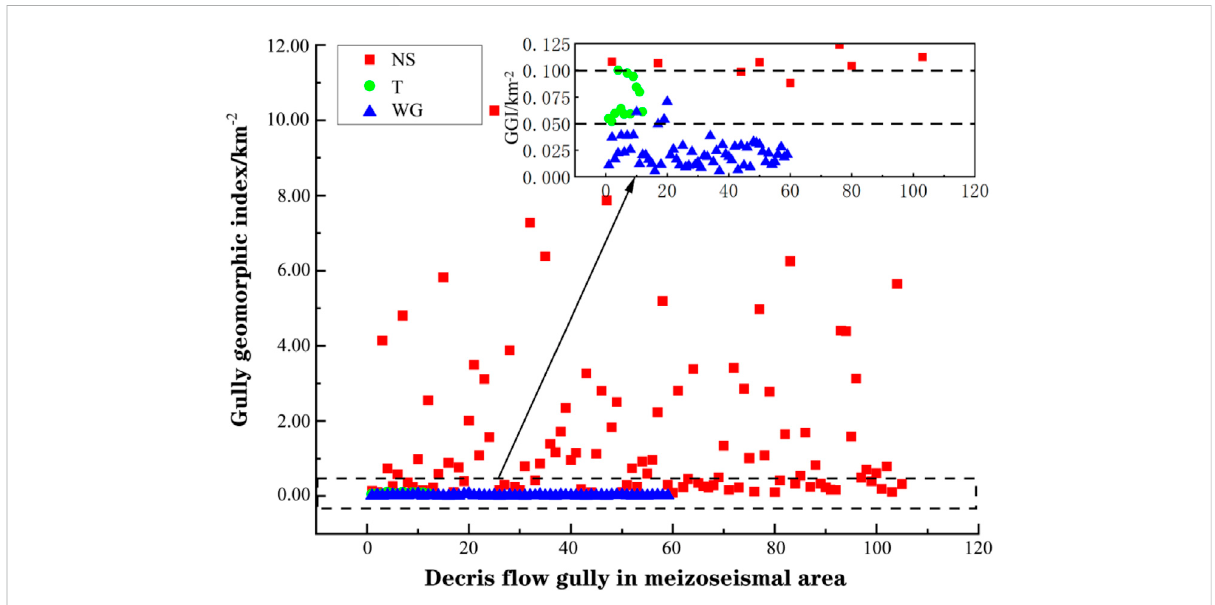
FIGURE 8 The classi fi cation results of 176 gullies by the two methods.